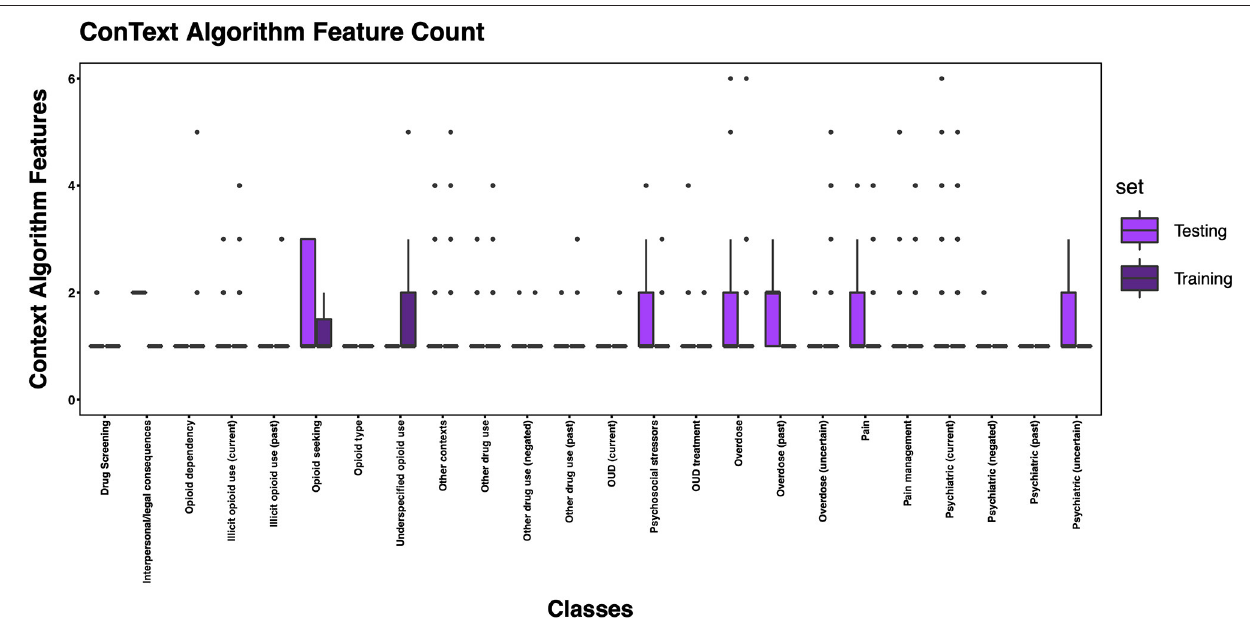
FIGURE 7 | Boxplot of the mean count of contextual features per class, comparing training and testing sets.